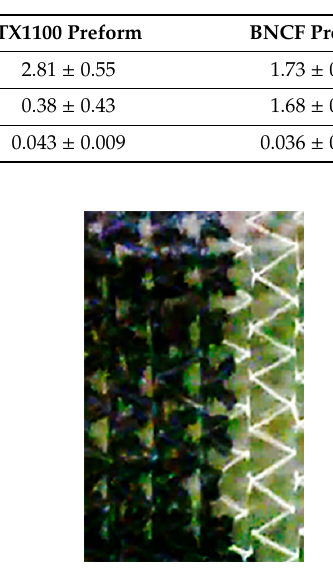
Table 1. Permeabilities of the carbon fiber fabrics.